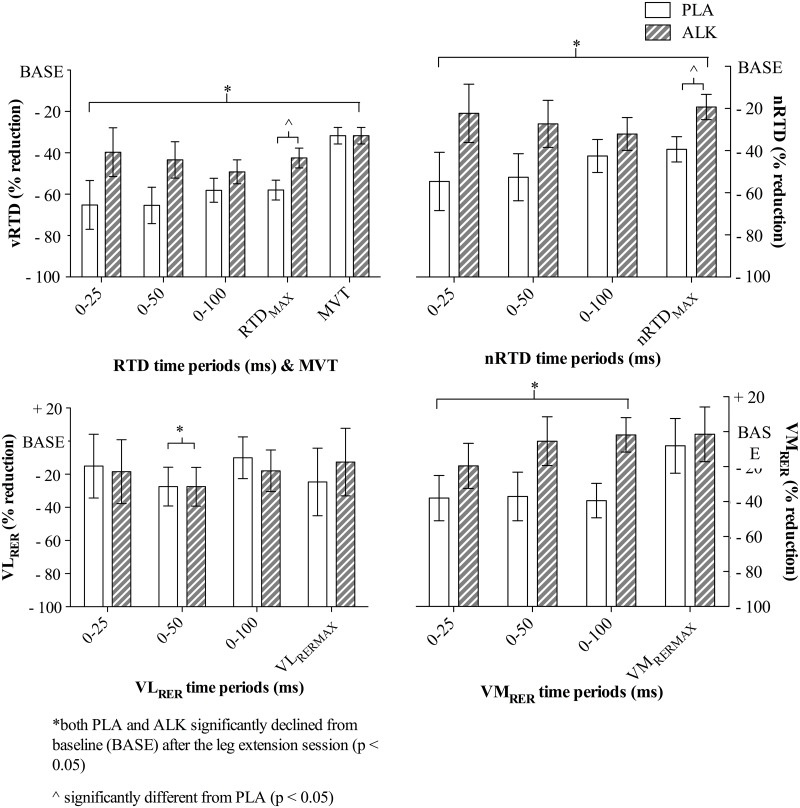
Percentage change (%) determined from measurements taken at rest (BASE) and immediately after the leg extension session in Study 1.Voluntary rate of torque development (vRTD), rate of torque development normalised to the corresponding maximal voluntary contraction (nRTD), and rates of EMG rise for vastus lateralis (VLRER) and vastus medialis (VMRER) normalised to the superimposed M-wave (%); Figure includes the maximal rate and the time periods (0–25, 0–50 and 0–100 ms) associated with these measurements; (ALK) alkalosis, (PLA) placebo (PLA), data are mean ± SEM.